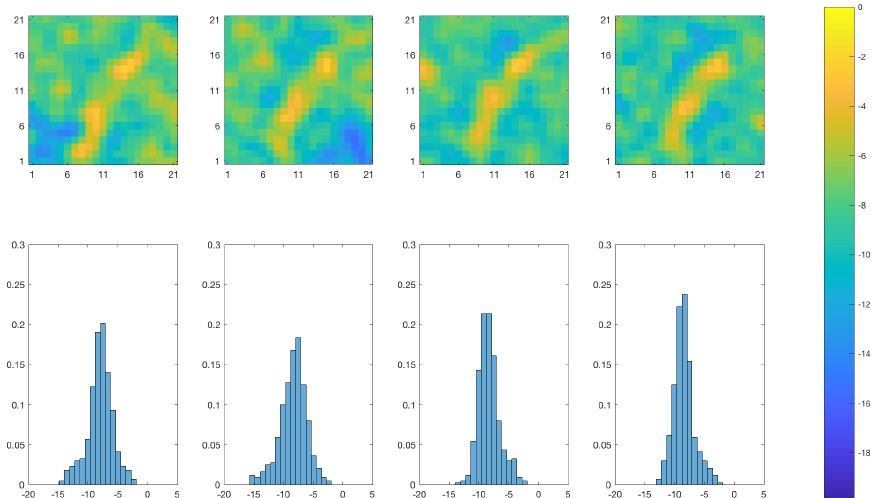
Figure 11. EnKF approach: Realizations of the posterior distribution of the log diffusivity f ( log ( λ ) | d 0: T ) at time T = 100 ( upper panels) and associated spatial histogram ( lower panels). Lower panels: the horizontal axes represent the log-diffusivity, the vertical axes represent the relative prevalence of each log-diffusivity value for the realization in the panel right above.